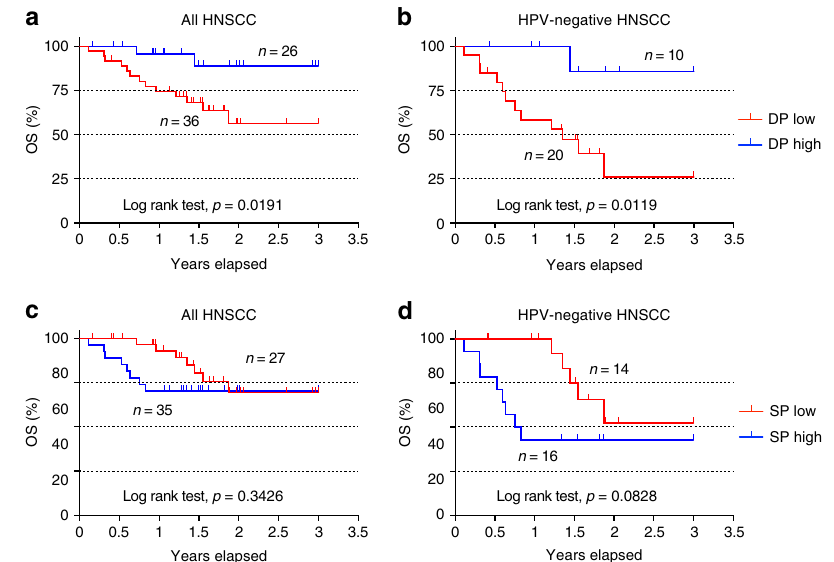
Fig. 7 High frequency of DP CD8 TILs is associated with better overall survival in a cohort of HNSCC patients. Following surgery, the frequency of DP ( a , b ) and SP ( c , d ) CD8 T cells among total CD8 TILs was determined within the primary tumor by fl ow cytometry. a HNSCC patients ( n = 62) were segregated based on the frequency of the DP CD8 T cells, with DP high and DP low groups strati fi ed above or below the mean frequency (32.9%) followed by Kaplan – Meier analysis. b Similar analysis performed on the HPV-negative HNSCC patients ( n = 30). c HNSCC patients ( n = 62) were segregated based on the frequency of the SP CD8 T cells, with SP high and SP low groups strati fi ed above or below the mean frequency (18%) followed by Kaplan – Meier analysis. d Similar analysis performed on the HPV-negative HNSCC patients ( n = 30). The log-rank test was used to compare curves and p -values <0.05 were considered signi fi